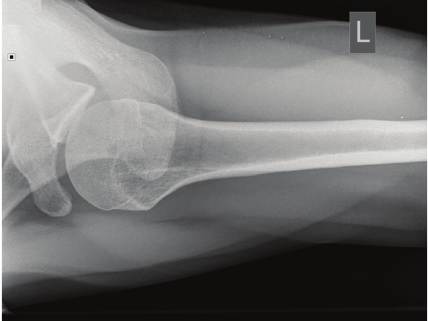
Figure 5: Image showing the asymmetry between the shoulders and red line illustrates the normal contour of the shoulder as drawn from the right shoulder.